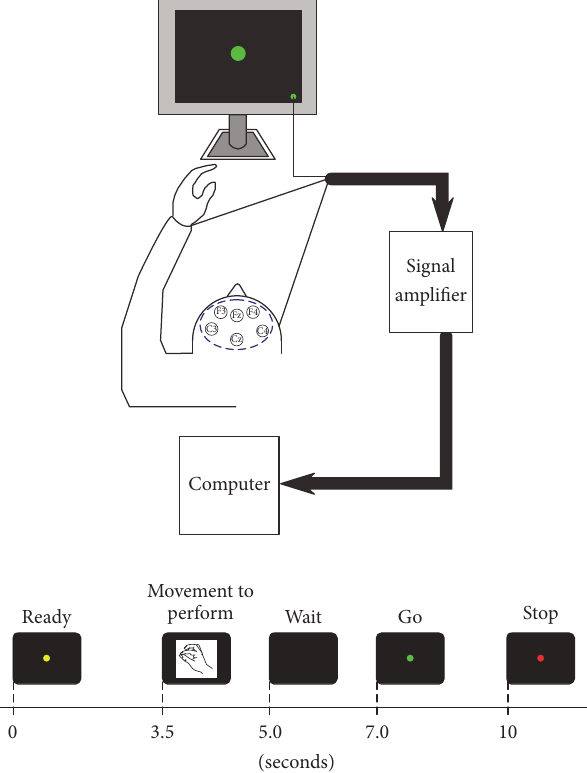
Figure 2: Experimental sequence used during calibration of the brain-computerinterface.Theparticipantsatcomfortablyinfrontof a computer monitor that provided cues indicating when to attempt specific movements with his paralyzed hand. These movements included precision pinch, hand closing (fist), lateral pinch, and hand opening and were presented at random.